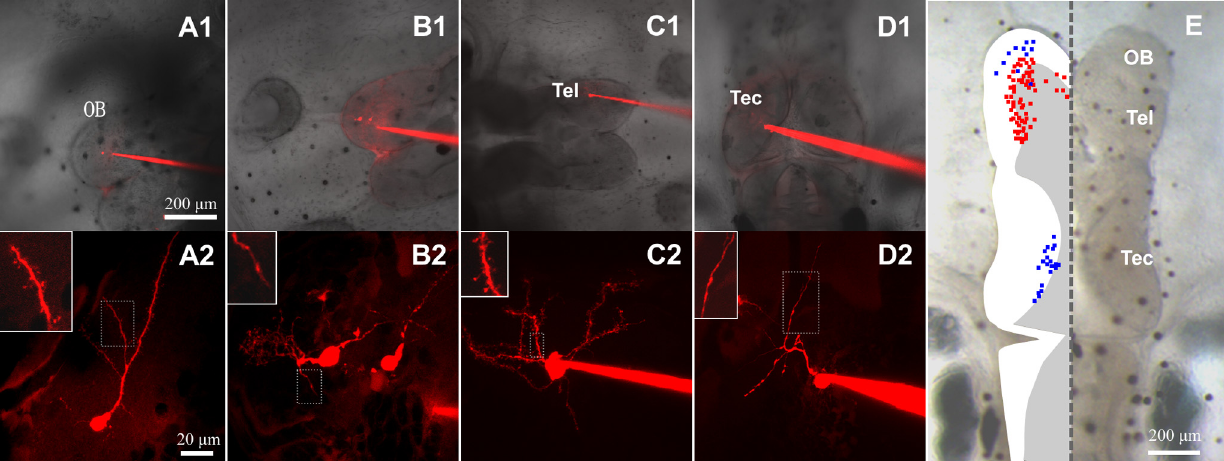
Fig 1. Distribution of spiny neurons in the Xenopus tadpole brain. Fluorescent dye was electroporated into neurons located in different brain regions. (A1, A2) Spiny neuron in the OB. (A1) Electrode filled with fluorescent dye inserted into the OB, pointing to a labeled neuron. (A2) High magnification of the neuron in A1. Inset shows spines on a dendrite. (B1, B2) Mitral cell in the anterior OB. (C1, C2) Spiny neuron in the telencephalon (Tel). (D1, D2) Non-spiny neuron in the tectum (Tec). (E) Diagram summarizing all labeled spiny (red) and non-spiny (blue) neurons in different brain areas in the left hemisphere. Twenty neurons randomly labeled in the optic tectum were non-spiny neurons; 69 neurons in the OB and telencephalon were spiny neurons except for 11 neurons.